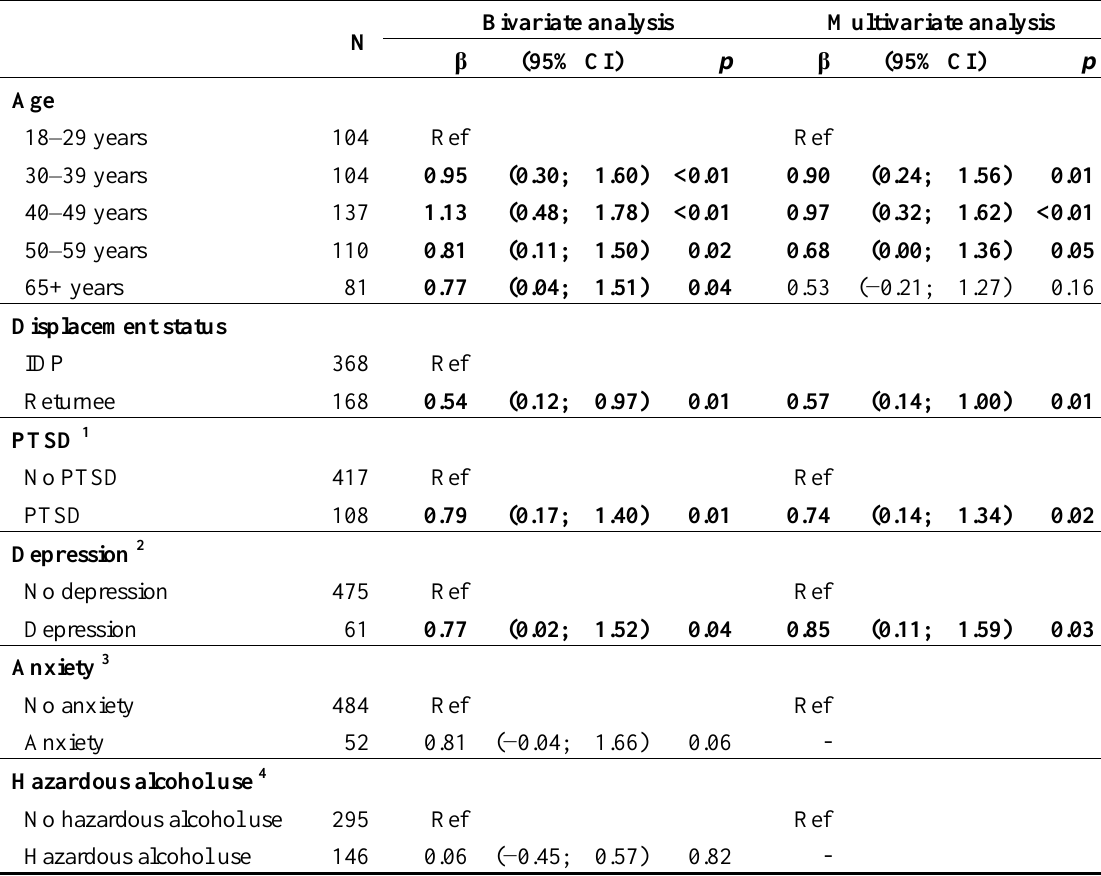
β, beta coefficient; CI, confidence interval. 1 Score of >5 on the TSQ instrument. 2 Score of ≥10 on the PHQ-9 instrument. 3 Score of ≥10 on the GAD-7 instrument. 4 Score of ≥8 on the AUDIT instrument. - Not entered into multivariate analysis as not significant in the bivariate analysis. Separate models runs for PTSD and depression. Data in bold signify statistically significant results ( p <